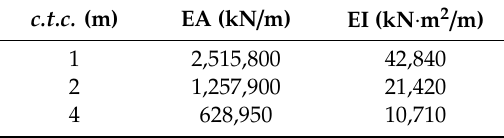
Table 5. H-pile parameters (linear elastic